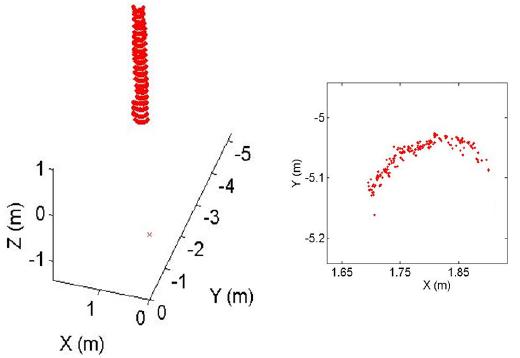
Figure 8. The point cloud of Pole 1captured by Faro Focus 3D (8a, left) and its projected cross section on the XY -plane (8b, right)